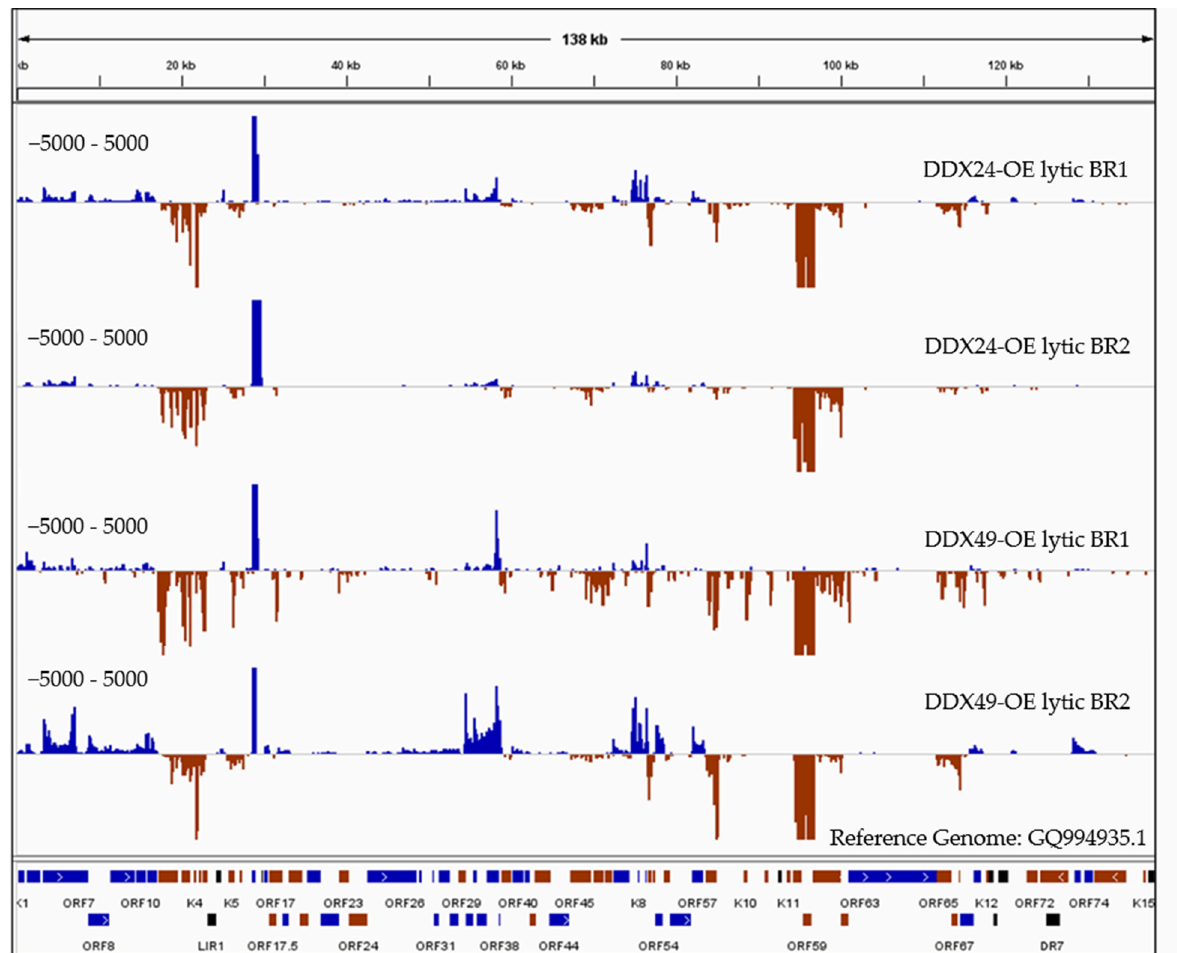
Figure 6. RNASeq coverage analysis of DDX24 and DDX49 associated KSHV transcripts compared to the control immunoprecipitated RNA upon Rta-induced reactivation. RNA samples immunoprecipitated using anti-Avi from DDX24/TREx BCBL1-Rta, DDX49/TREx BCBL1-Rta and control transfected TREx BCBL1-Rta cells were subjected to Illumina strand-specific Next Generation Sequencing analysis. The plot here represents the distribution of read counts per million (CPM) in DDX overexpressing samples normalized by subtracting the corresponding CPM values in control sample mapped along the annotated KSHV genome on the x -axis. The y -axis is showing the number of reads (coverage) on the positive or negative strand of the genome (blue and red).